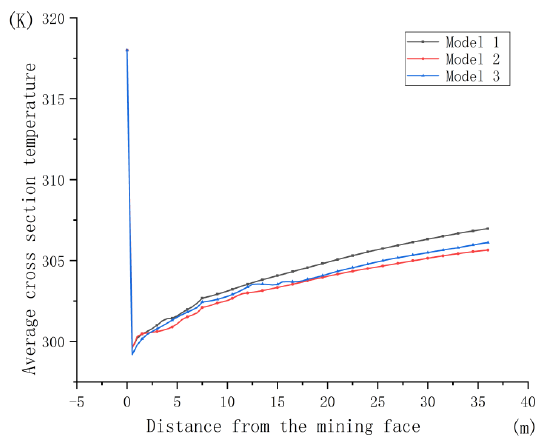
Figure 2. Models 1–3 section average temperature curve.